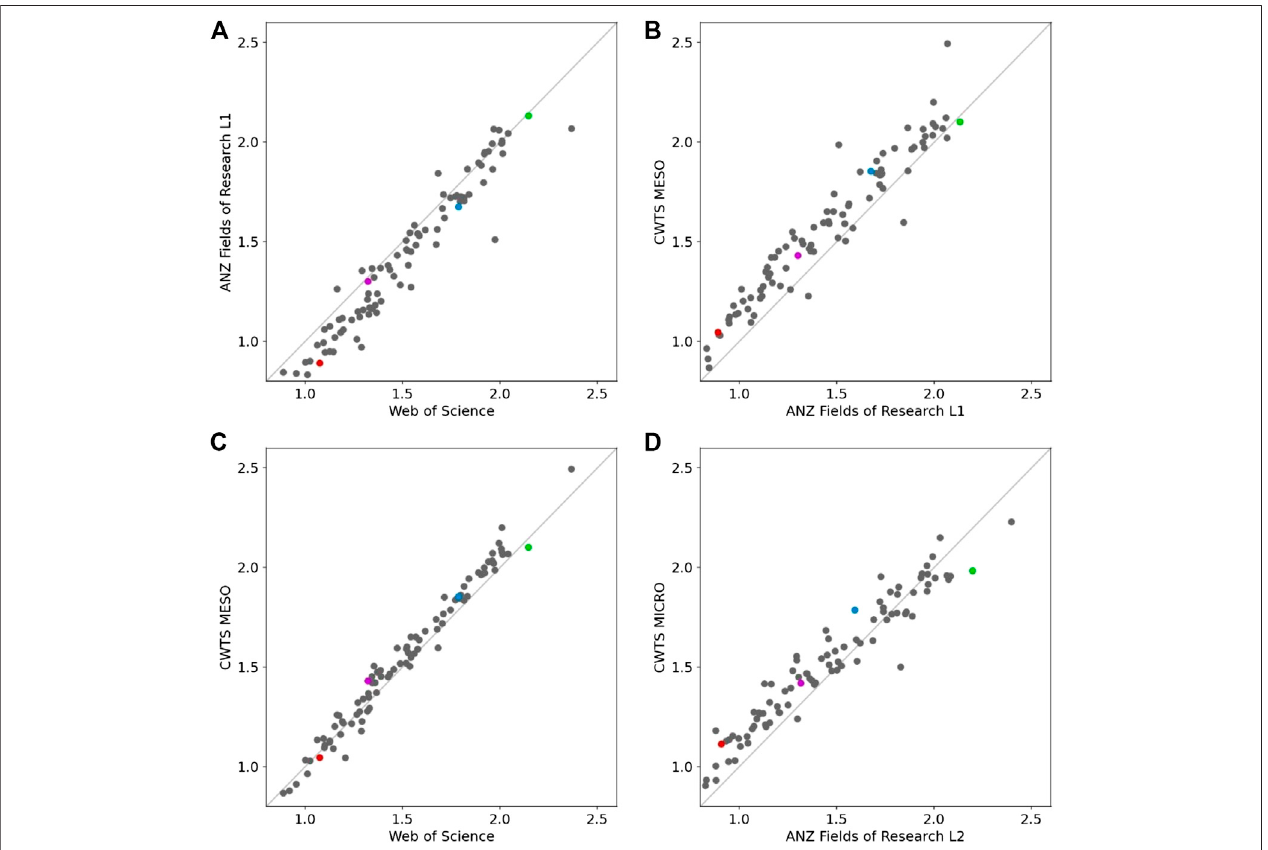
Figure 2 | (A) – (D) Correlations between the average Category Normalized Citation Impact (CNCI) of United Kingdom universities ( Web of Science indexed publications for 2015 – 2019) when different schema (see Note) are used to categorize the institutional and global publication data. In each case the correlation is highly signi fi cant but the variance about the regression differs for speci fi c institutions. Four universities with distinct research histories and portfolios are highlighted with a constant color point. ( Web of Science (WoS) categories map journals to 254 fi elds; ANZSRC Fields of Research (FOR) use L1 (cid:1) journals mapped to 24 broad categories and L2 (cid:1) 212speci fi c categories nested withinL1; CWTS MESO and MICROreferto coarse and fi ne citation-based categories developed byCWTS, Univof Leiden). (A) FOR1vs.WoS, n (cid:1) 86,correlation (cid:1) 0.968. (B) CWTSMesovs.FOR1, n (cid:1) 86,correlation (cid:1) 0.954. (C) CWTSMesovs.WoS, n (cid:1) 86,correlation (cid:1) 0.986 (D) CWTS Micro vs. FOR2, n (cid:1) 86, correlation (cid:1)